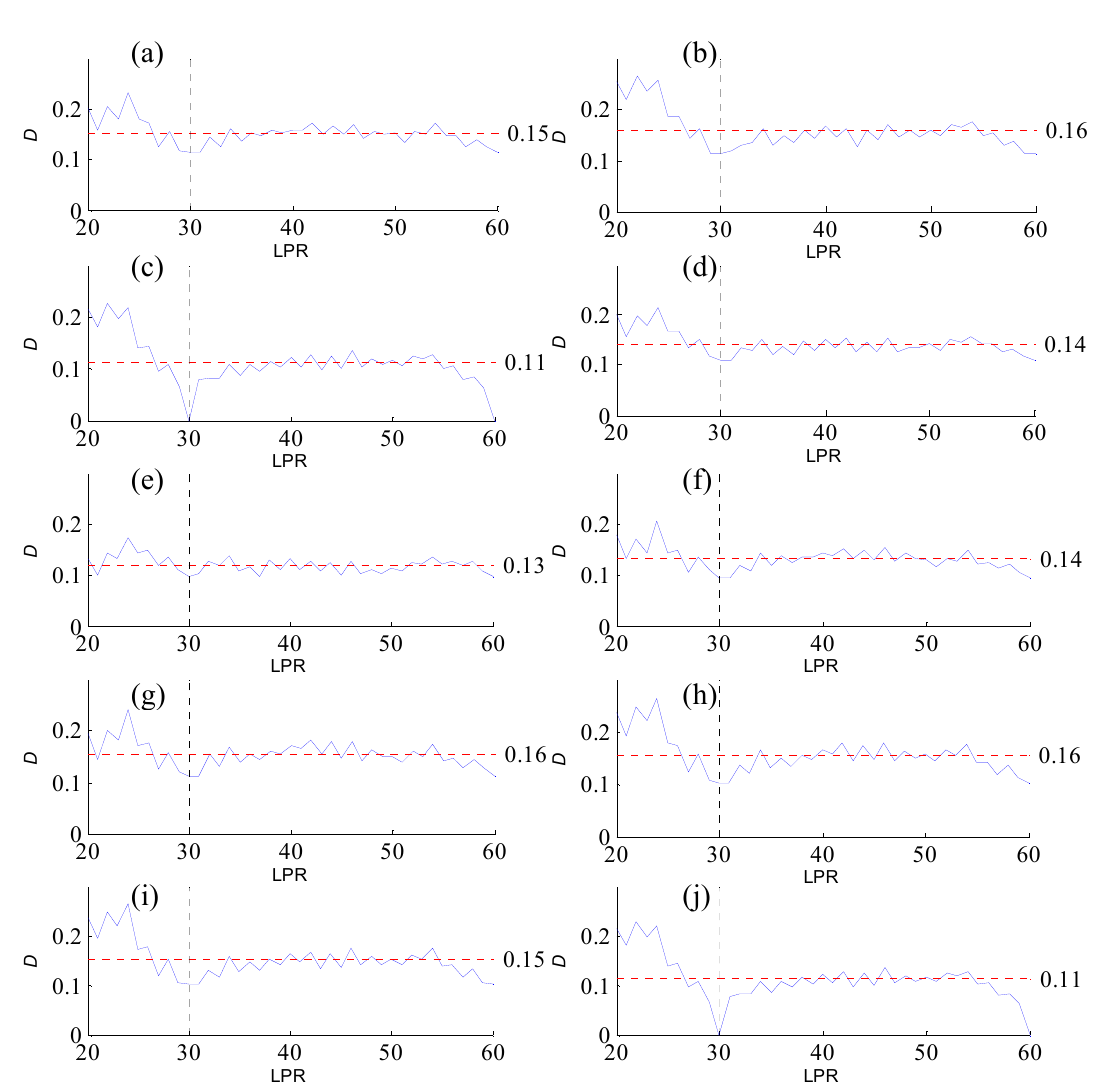
Figure 2. Variation of flow regime alteration degree (D) measured by the RVA with the changes in length of post-impact flow time series (LPR) under a periodicity of 30 years. ( a – j ) correspond to a pre-impact flow time series length = 21, 26, 30, 34, 39, 43, 47, 51, 56, and 60 years, respectively. The abscissa value for the vertical dotted line is 30. The ordinate value for the horizontal dotted line is the mean degree of flow regime alteration in each subfigure.